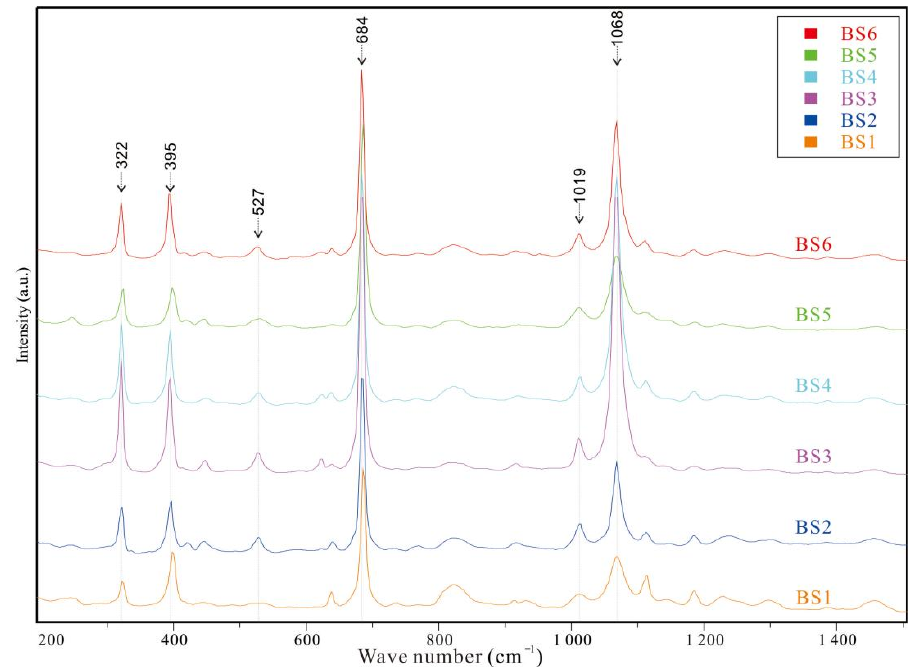
Figure 3. Raman spectra of the beryl samples. The main beryl Raman bands were found at ~322, ~395, ~527, ~684, ~1019, and ~1068 cm − 1 .